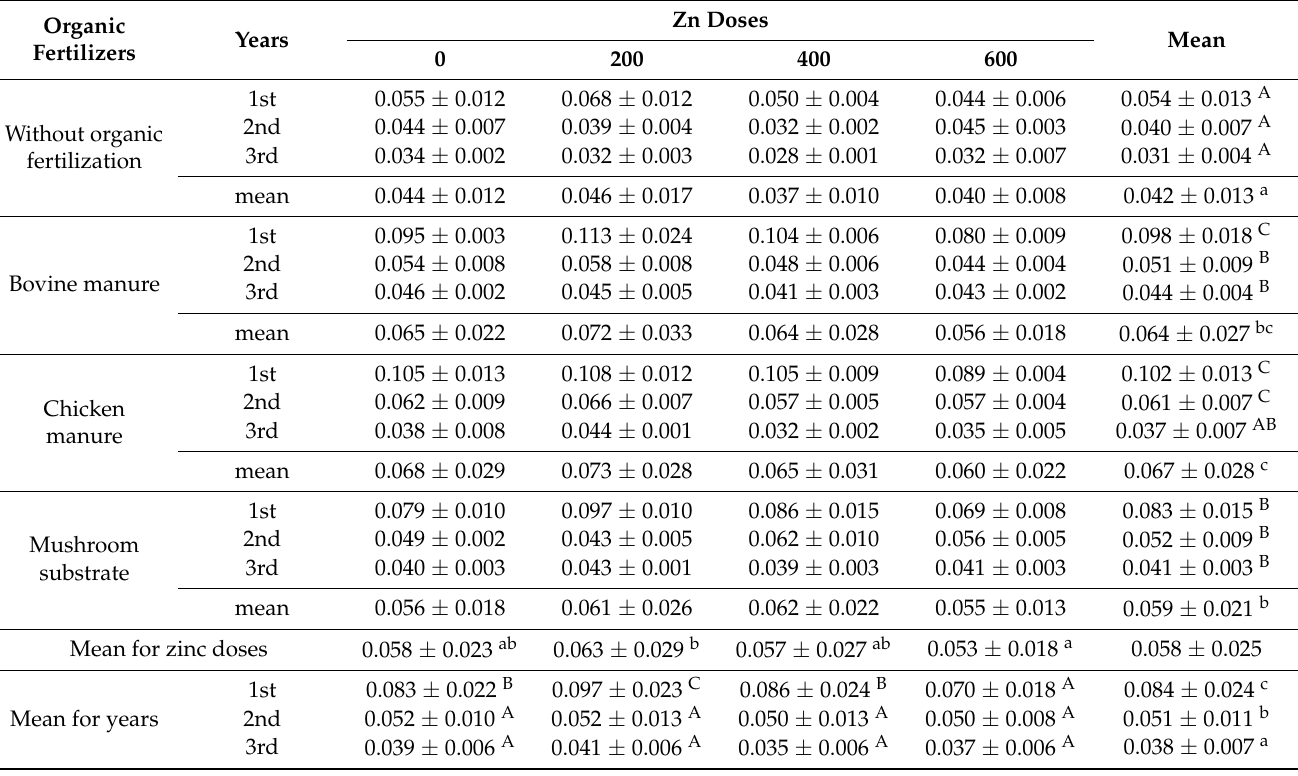
Table 3. Phosphorus uptake (P g · pot − 1 ) by cocksfoot under different zinc doses (Zn mg · kg − 1: of soil) and organic fertilization (mean ± SD).